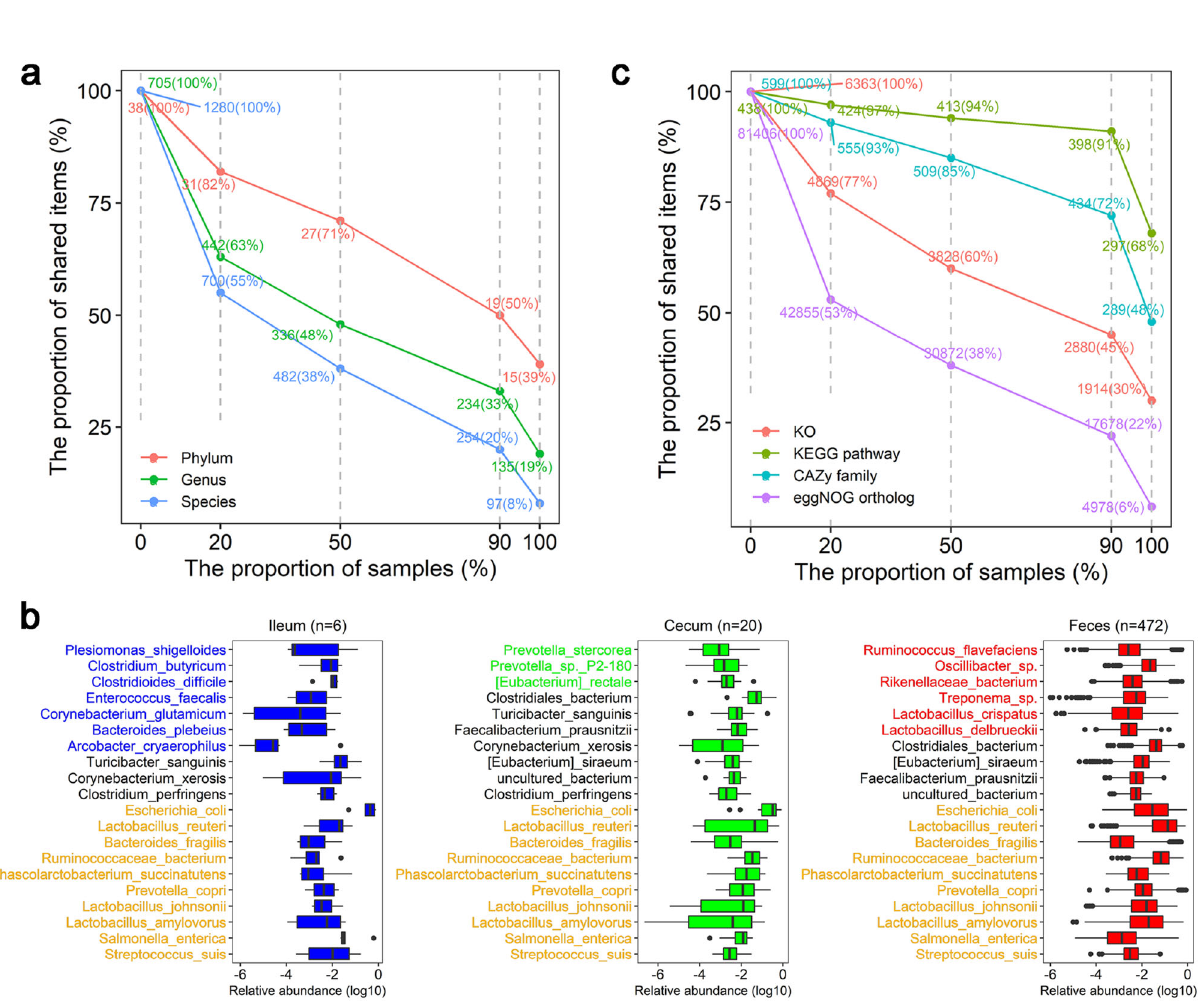
Fig. 3 Core bacterial taxa and functional capacities of pig gut microbiome. a Numbers (percentages) of shared bacterial taxa among different proportions of samples at the phylum (red), genus (green), and species (blue) level. The percentage of shared items and the proportion of shared samples are represented on the y - and x -axis, respectively. The number and the percentage for each item that are shared in 20, 50, 90, and 100% of samples are indicated in the Figure. Nineteen phyla, 234 genera, and 254 species were shared in 90% samples and de fi ned as core bacteria. b The top 20 bacterial species in relative abundances in ileum lumen, cecum lumen, and feces, respectively. The yellow color indicates the species in the top 20 lists of all three gut locations, and the colors corresponding to boxplots show the top 20 species speci fi c to each gut location. The log 10 (relative abundance) values are shown on the x -axis. c Numbers (percentages) of shared function items among different proportions of samples for KEGG orthologues (red), KEGG pathways (olive), CAZy family (cyan), and eggNOG (purple). Other legends are like ( a ). Boxplots show median, 25th and 75th percentile, the whiskers indicate the minima and maxima, and the points laying outside the whiskers of boxplots represent the outliers.